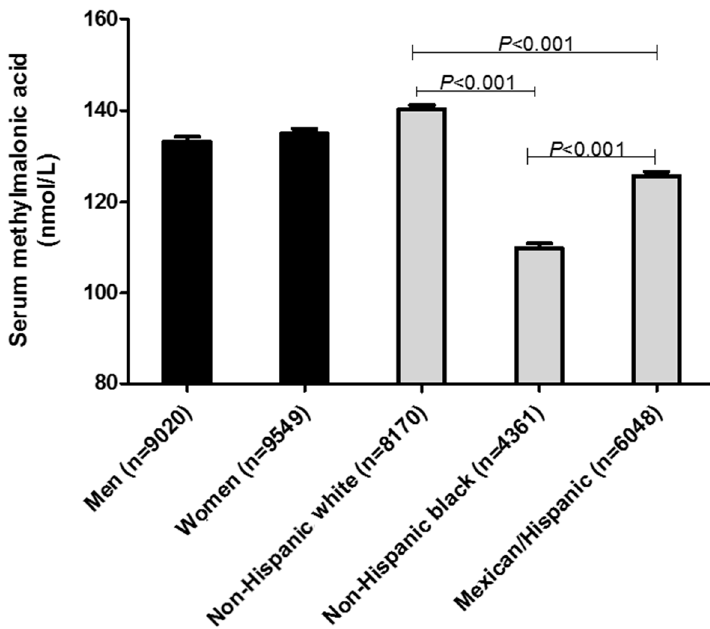
Figure 1. Adjusted sex and race-ethnicity-stratified geometric mean concentrations of serum methylmalonic acid (MMA) in ≥ 12 years old persons in the US ( n = 18,569). National Health and Nutrition Examination Surveys 1999–2000, 2001–2002 and 2003–2004, conducted after the folic acid fortification commenced, were combined into one analytic data set, 1999–2004. Values for men and women were adjusted for race-ethnicity, age, supplement use, serum creatinine and serum vitamin B-12. Values for race-ethnicity were adjusted for sex, age, supplement use, serum creatinine and serum vitamin B-12. Adjusted serum MMA concentrations were not significantly different between men and women ( p < 0.11). Adjusted serum MMA concentrations were significantly different between three races ( p < 0.001). Analysis was performed on log serum MMA concentrations to satisfy normality.